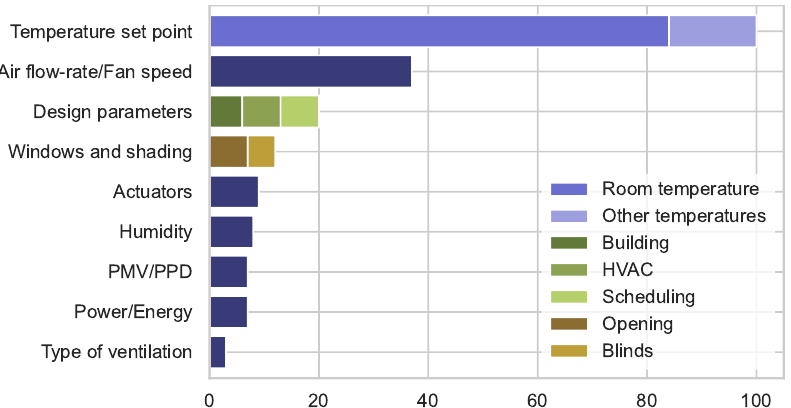
Figure 11. Variables and settings for thermal-comfort-based control in the analyzed